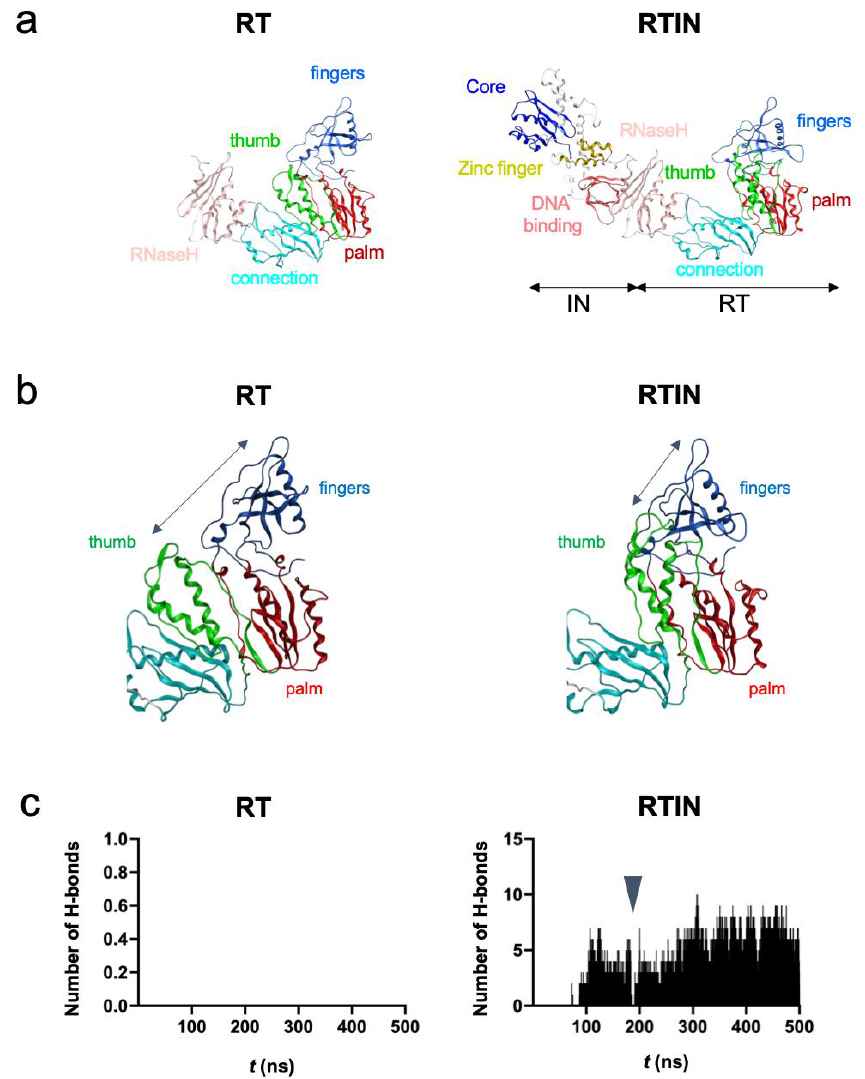
Figure 7. Effects of IN fusion on conformation of RT protein. Structures obtained from the MD simulations in Figure 6 were used to characterize impacts of RTIN fusion on RT. ( a ) Comparison between overall structures of RT and RTIN fusion protein at 500 ns of MD simulations. ( b ) Enlarged view of active center of RT in RT and RTIN fusion protein at 500 ns of MD simulations. ( c ) Numbers of hydrogen bonds formed between the thumb and fingers subdomains of RT during 500 ns of MD simulations. The trajectory files during 500 ns of MD simulations were used to calculate the number of hydrogen bonds between the fingers and thumb subdomains in the RT region using the cpptraj module in AmberTools 16